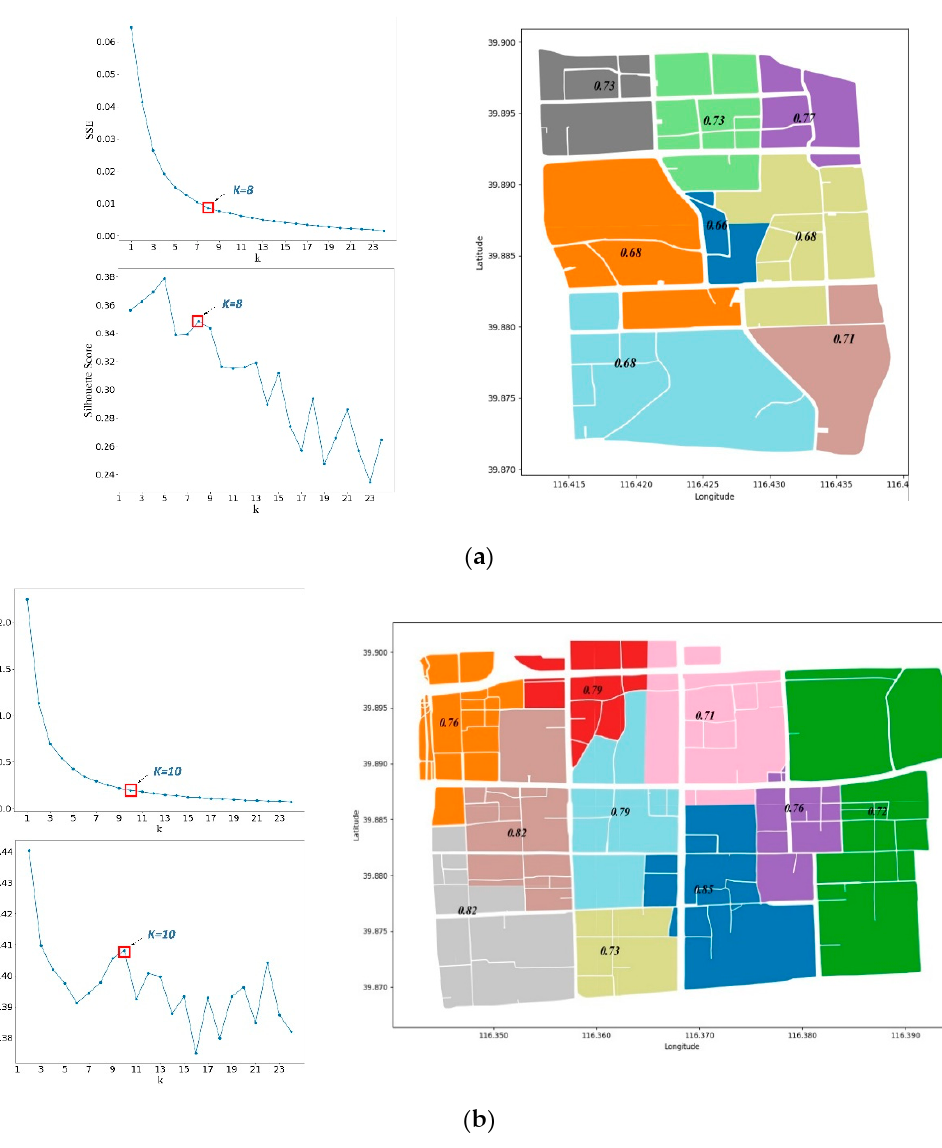
Figure 14. Illustration of parcel grouping results based on the k-means++ algorithm: ( a ) grouping result of Parcel 1 (k=8) and ( b ) grouping result of Parcel 2 (k=10). Numbers within a group illustrate the MLU index of the group. The left part of the figures illustrates the process of choosing the optimal cluster number.